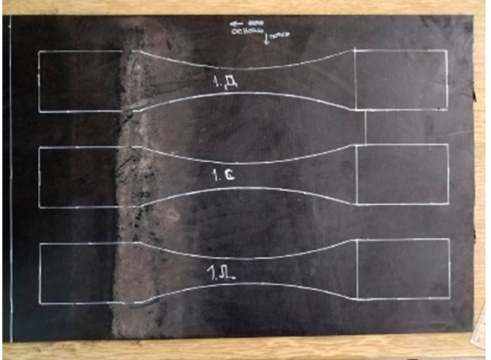
Figure 6. Specimens of conveyor belt EP 500/3 Y